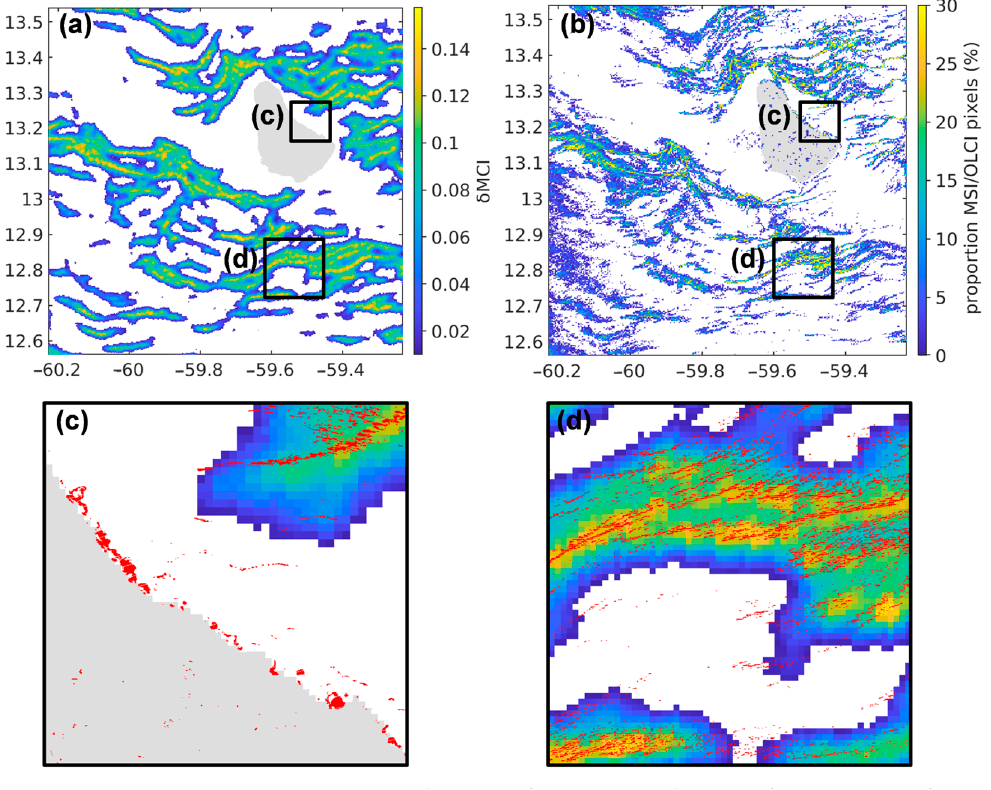
Figure 10. ( a ) Sargassum detections from CNN with OLCI; ( b ) proportion of MSI Sargassum pixels inside 1 OLCI pixel; and ( c , d ) Superposition of Sargassum detections from CNN with MSI (red) and with OLCI (color scale); ( c , d ) sub-images from ( a , b ). MSI image, PRV tile and OLCI image from